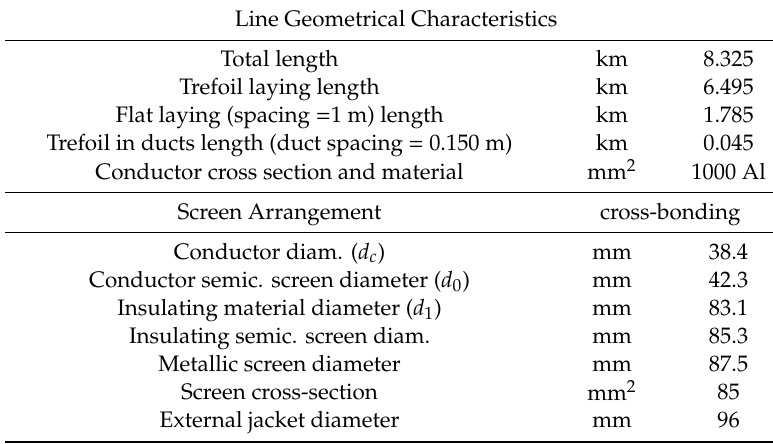
Table 1. Three single-core insulated cables of 132 kV in SE Calenzano-SE Rifredi RT.